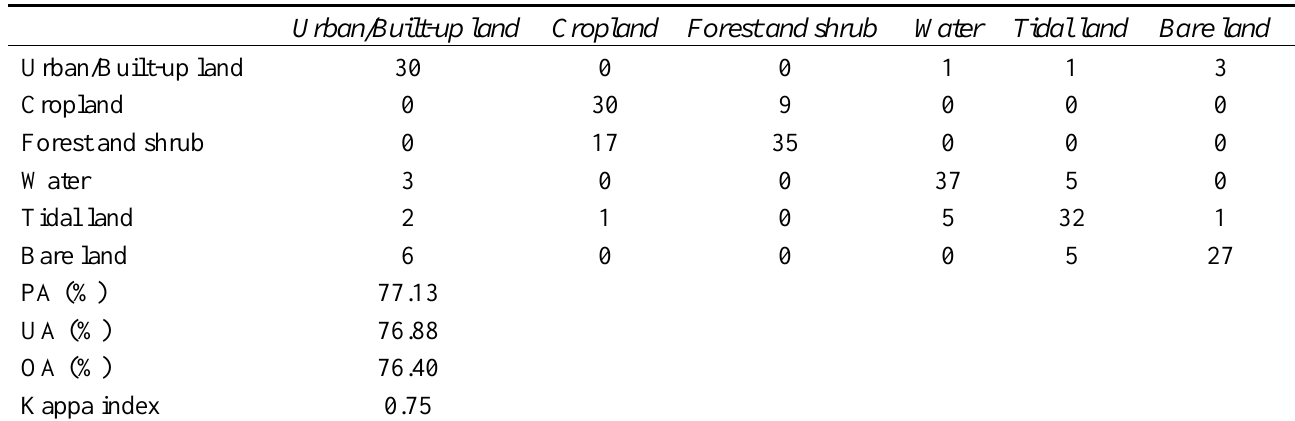
Table 1. 1979 accuracy assessment of land use classification (Kappa index and overall accuracy).